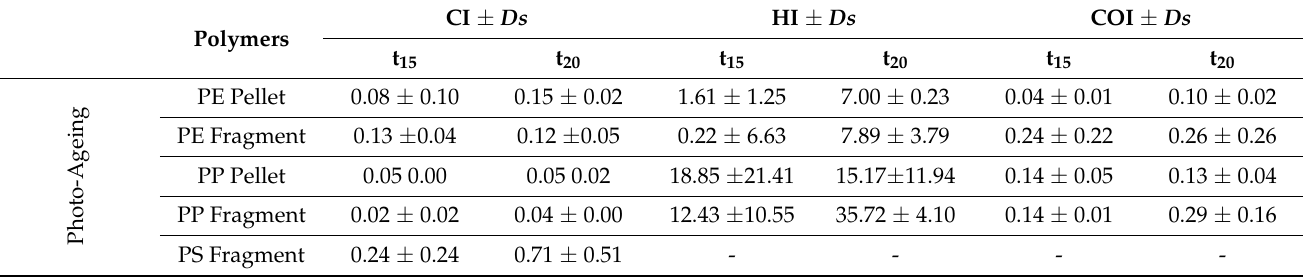
Table 3. Comparison of CI, HI, and COI calculated for each polymer. Values are expressed as an average of two replicates ± standard deviation ( Ds ) after 15 and 20 days of exposure to UVA rays in a climate